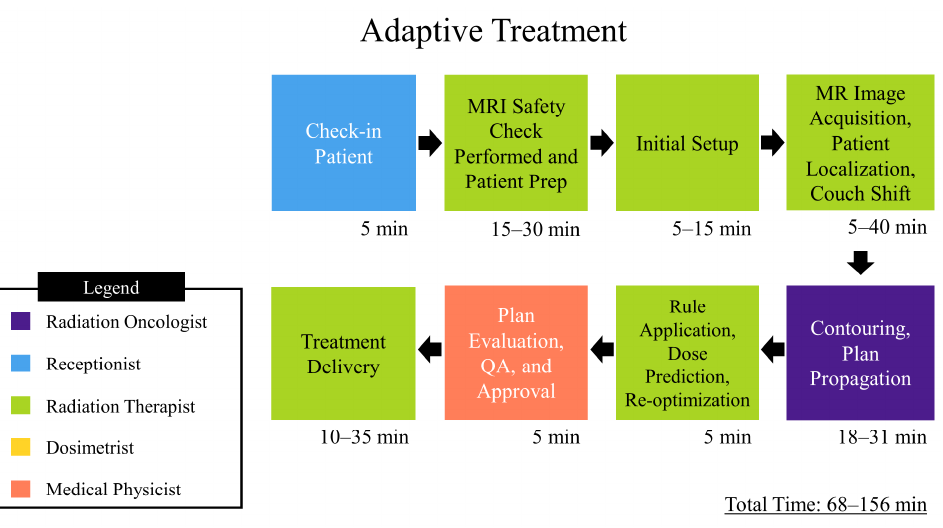
Figure 4. Depicts a process map for adaptive MRgRT. The times depicted are approximated from data gathered by VCU health staff.